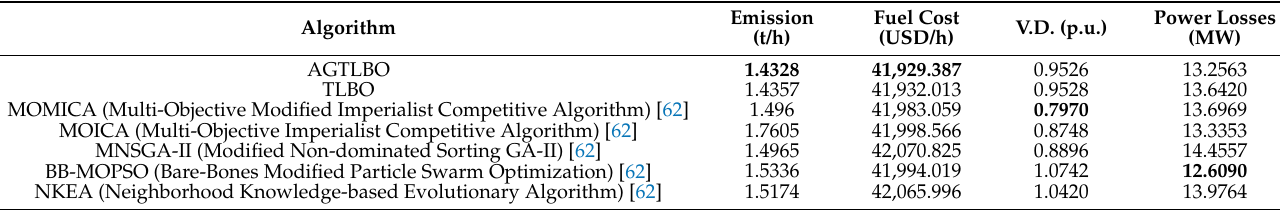
Table 14. Optimal results by different algorithms for Case